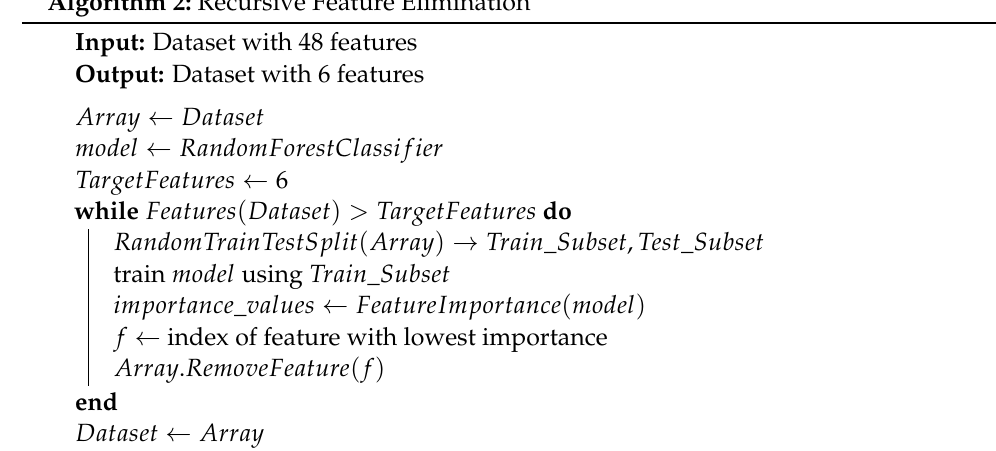
Algorithm 2: Recursive Feature